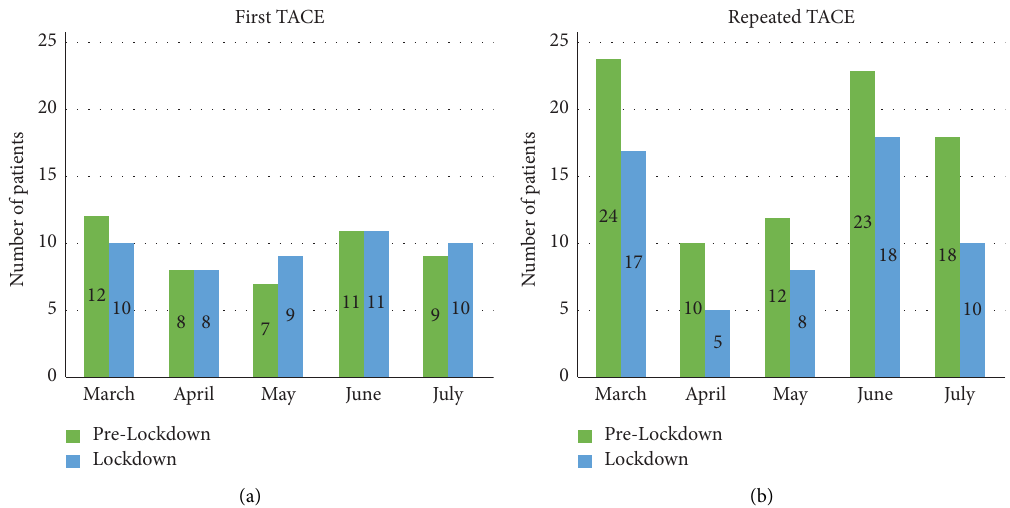
Figure 1: Numbers of patients with hepatocellular carcinoma during the prelockdown (March to July 2019) and lockdown (March to July 2020) periods who underwent frst transarterial chemoembolization (TACE) (a) and repeated TACE (b). Table 1: Details of TACE interval and TACE delay > 90days between the prelockdown and lockdown groups. Procedure Factors Prelockdown group